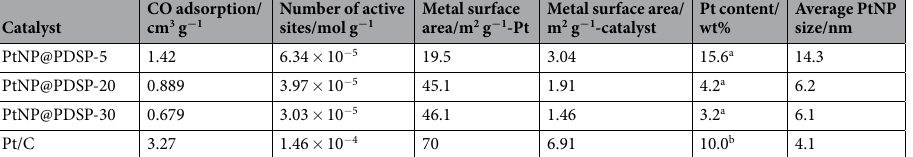
Table 2. Amount of CO adsorption, number of active sites, metal surface area, and average PtNP size of PtNP@ PDSP and Pt/C catalysts estimated by the CO pulse adsorption method. a Evaluated by ICP-AES. b Nominal